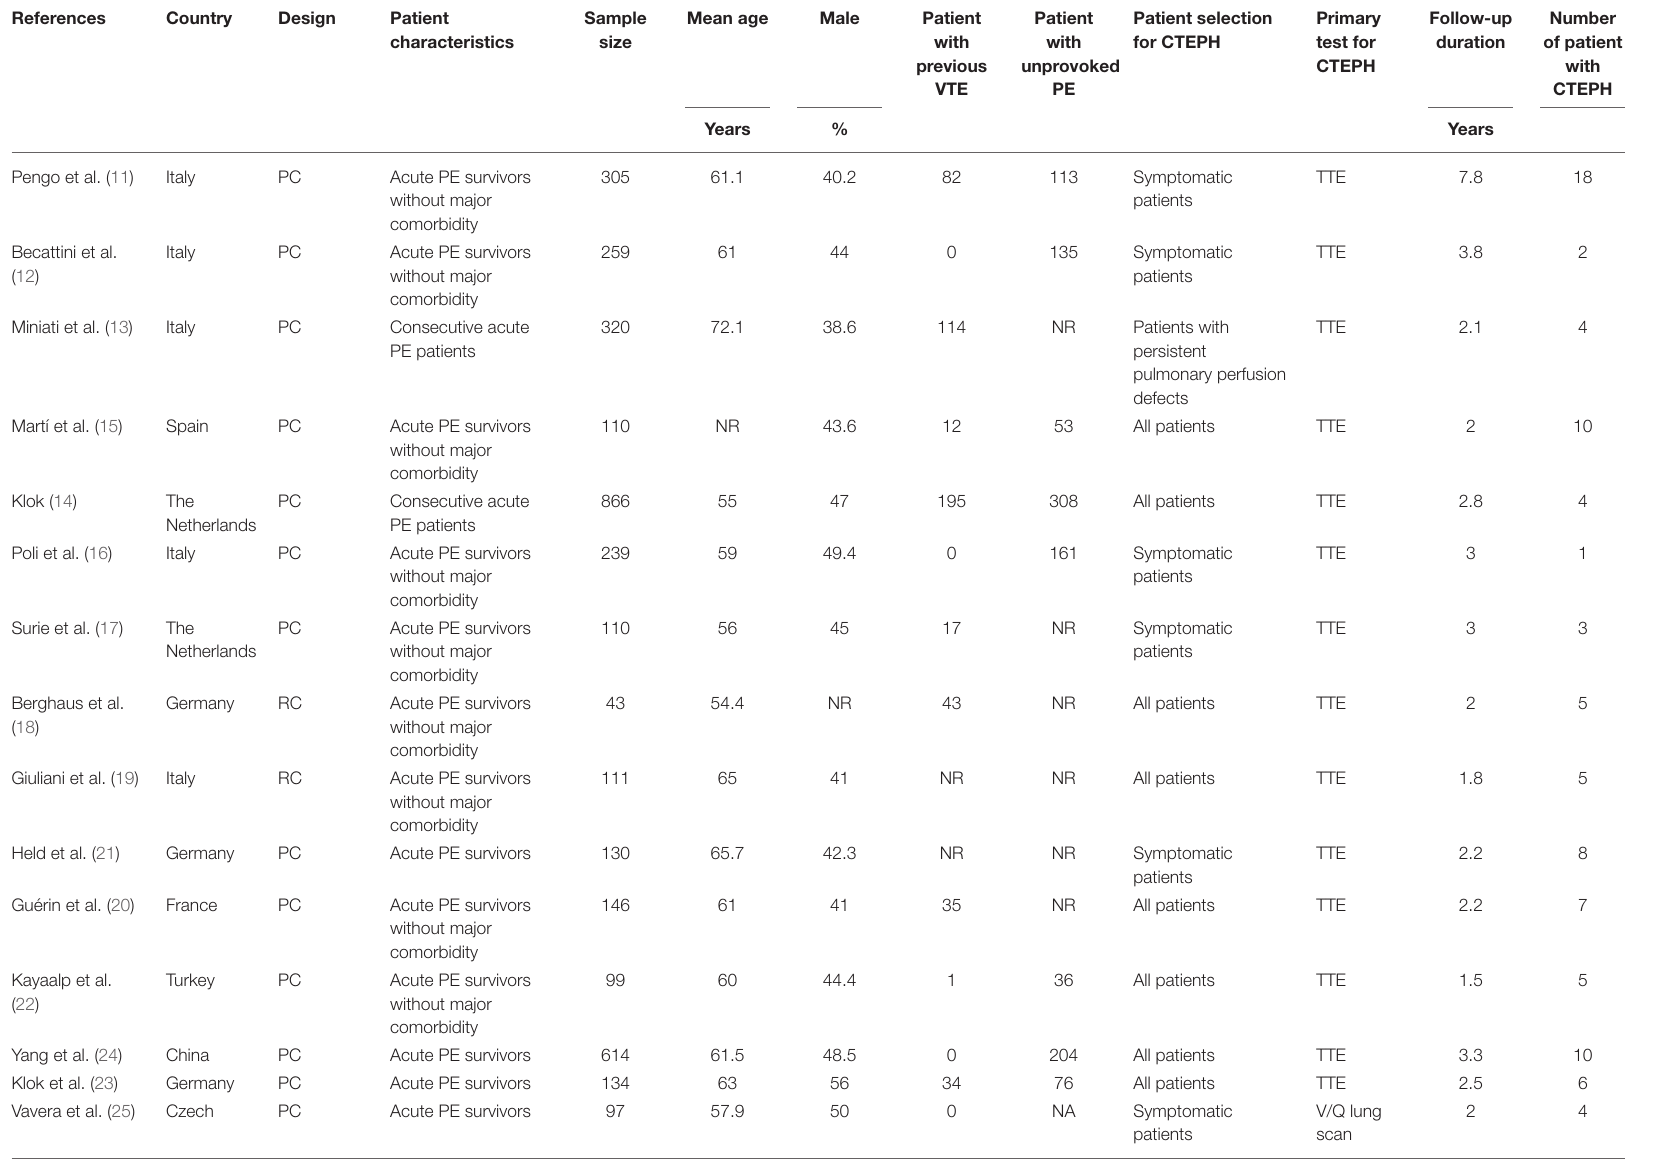
TABLE 1 | Characteristics of the included cohort